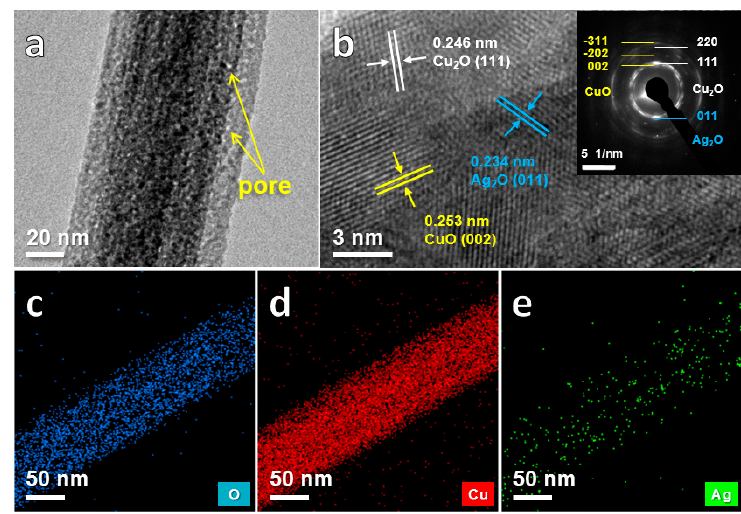
Figure 4. TEM images of the Cu x O/Ag 2 O-5 nanowires ( a ) high magnification image; ( b ) HRTEM image with the SAED pattern; the EDS elemental mapping images of ( c ) O; ( d ) Cu; ( e ) Ag.